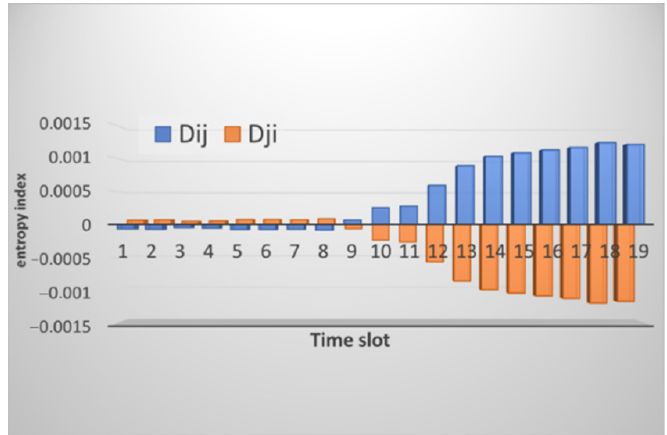
Figure 5. Result of calculating the entropy for the level of CPU utilization by node i relative to node j (marked in blue) and by node j relative to node i (marked in orange).